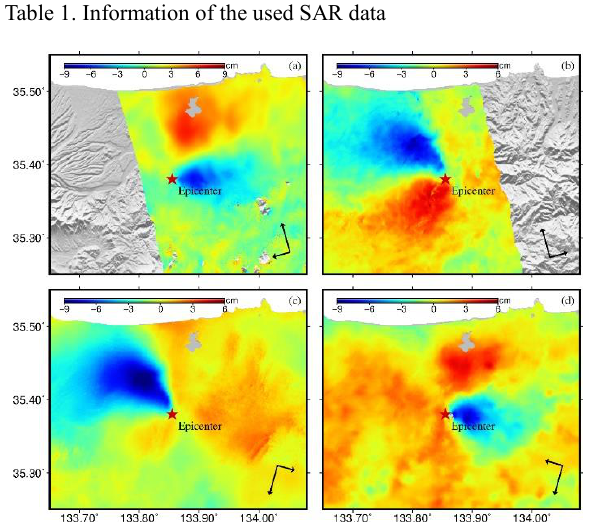
Figure 2. LOS deformation measurements of the central Tottori Earthquake along the (a) ascending left-looking, (b) ascending right-looking, (c) descending left-looking and (d) descending right-looking, respectively. Longer arrows correspond to along track directions and shorter ones indicate the LOS directions from satellites to ground points, respectively